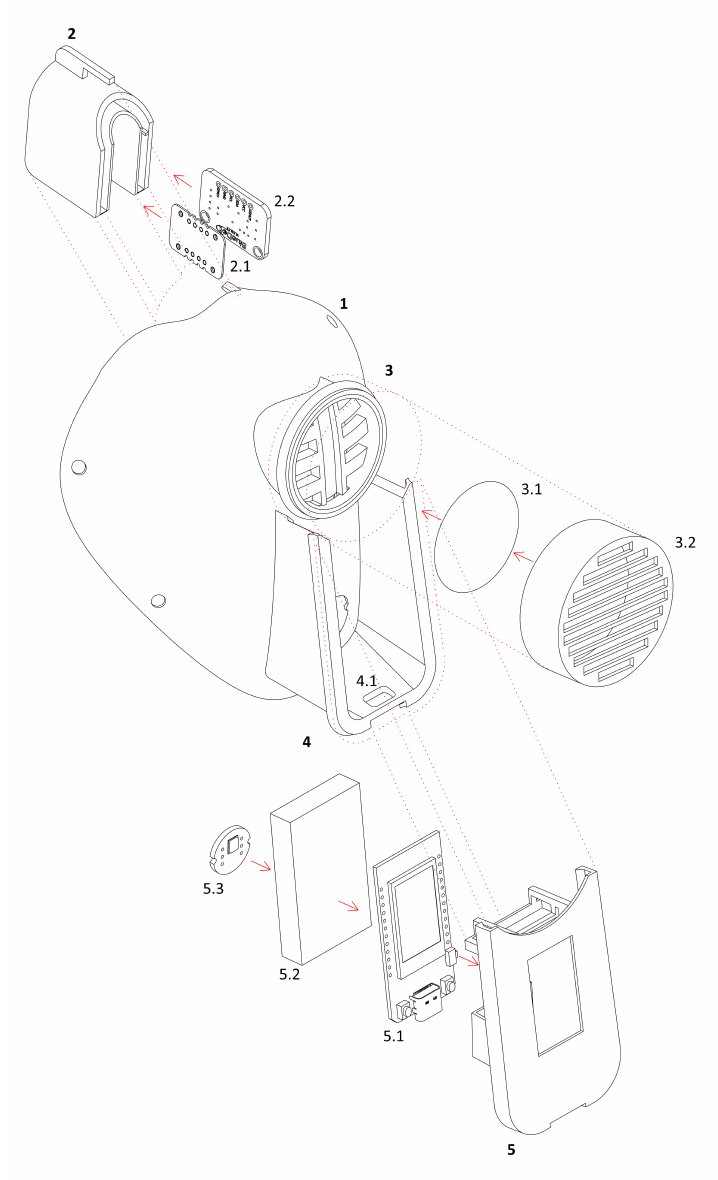
Figure 4. Graphic diagram showing an exploded three-dimensional enlargement of the (ME) 2 innovative mask (1) of Figure 1, from which it is possible to deduce its component parts, in particular: the nose-piece (2) of the mask (1), whose shape is suitable for contain a pair of sensors (2.1–2.2), in the two very small separate housings obtained in the oblong parts of the same nose pad, i.e., the heart rate and the blood oxygen saturation level sensor (2.1) and the temperature sensor (2.2), respectively; the mask body 3, comprising a support of the filter (3.1), in turn protected and enclosed within a filter cover (3.2); a support and containment medium (4) of the electronic board (5.1), the latter in turn inserted in a support cover (5), which can be constrained to a corresponding base (4.1) rigidly constrained to the body of the template (1) and also containing, together with it, the lithium battery (5.2) and microphone